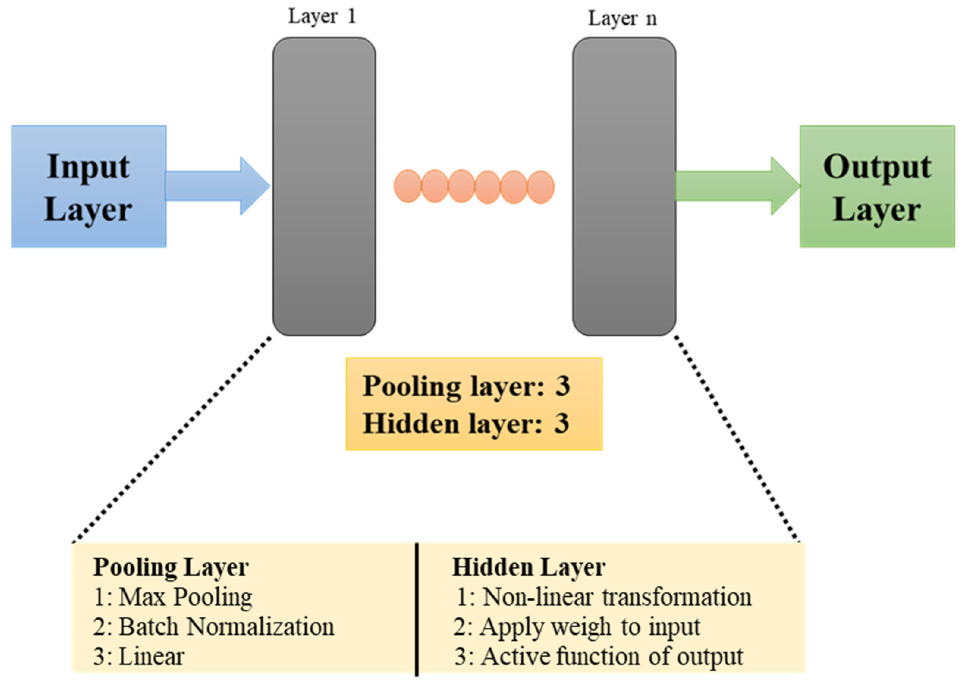
Figure 1. Proposed CNN model.